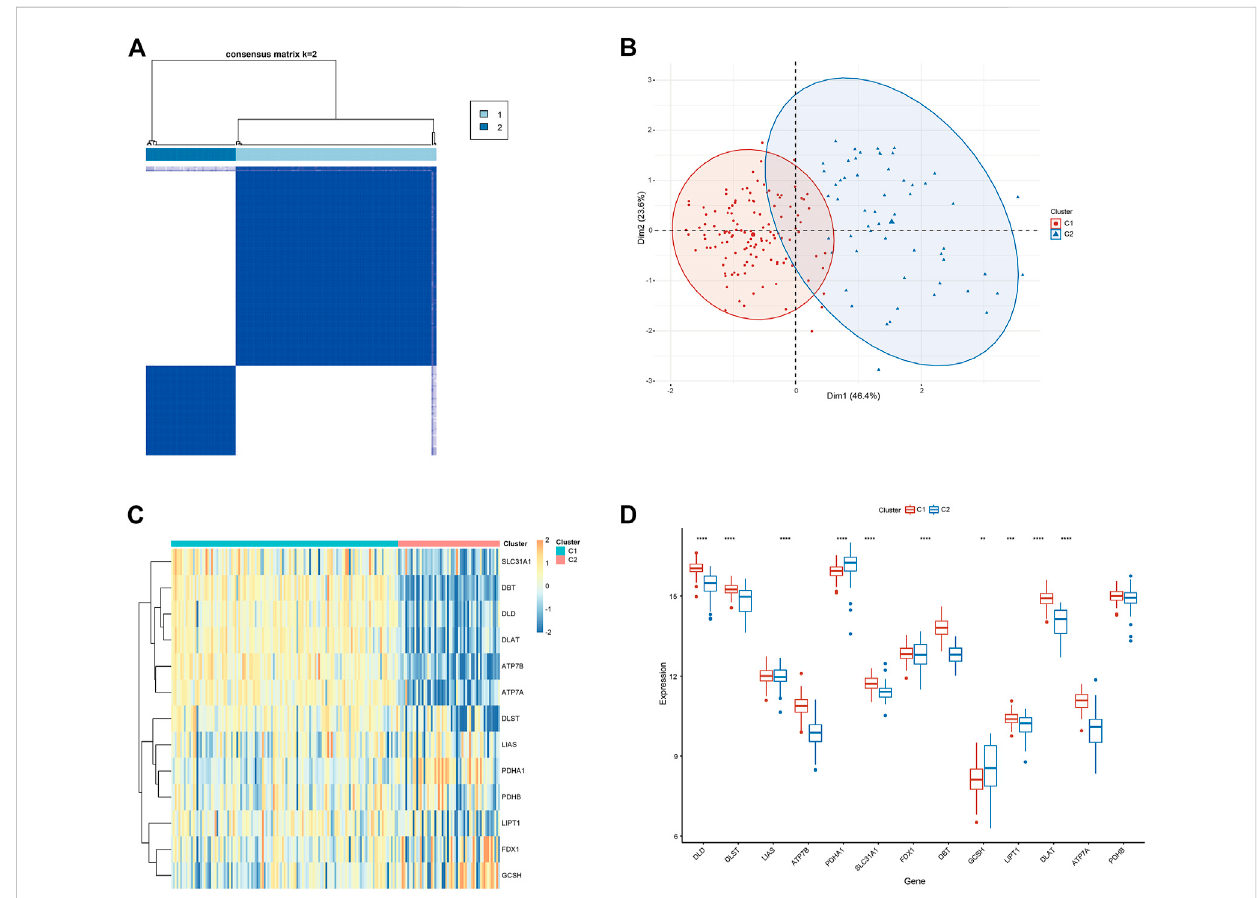
FIGURE 5 Identi fi cation of molecular clusters associated with cuproptosis in DCM. (A) Consensus clustering matrix at k = 2. (B) PCA visual analysis of two clustered distributions. (C) The heat map shows the expression of CRG between CRGcluster C1 and CRGcluster C2. (D) Box line plot showing the difference in expression between the CRGcluster C1 and CRGcluster C2. * p < 0.05, ** p < 0.01 *** p < 0.001, **** p < 0.0001, ns, not signi fi